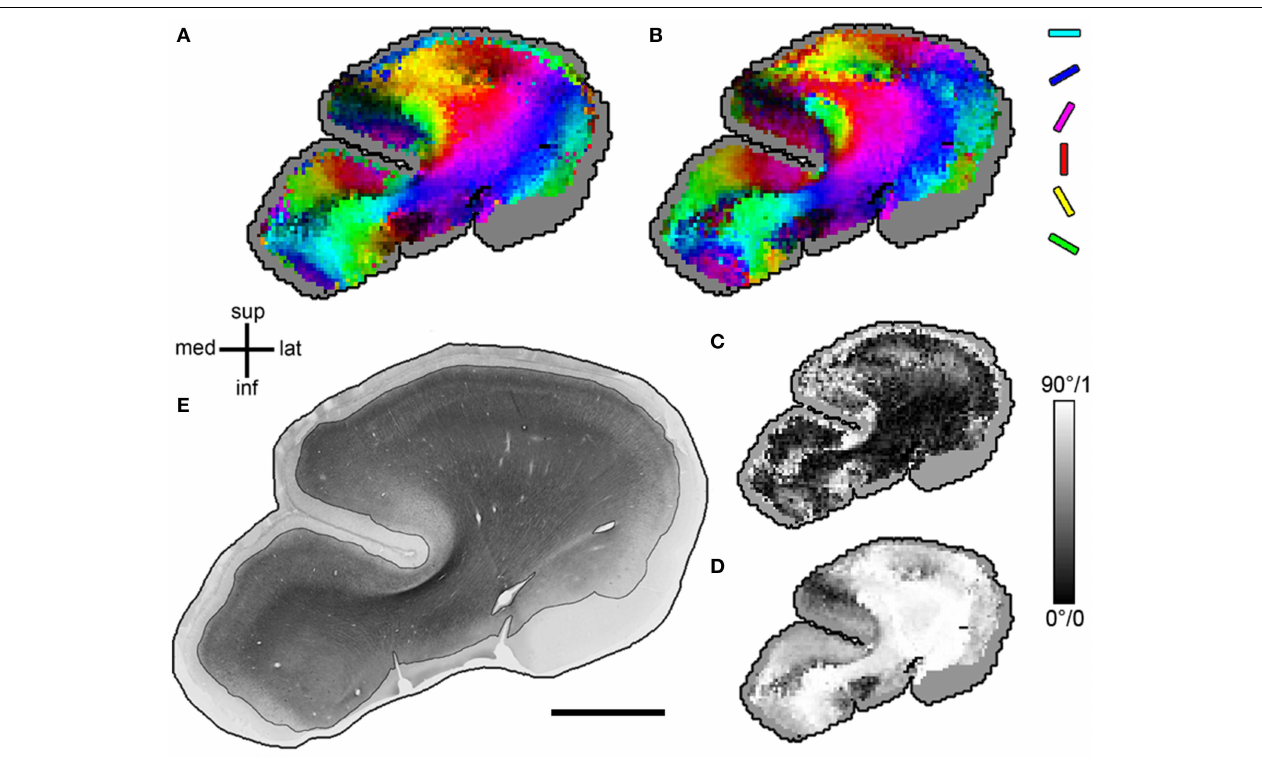
Mapping of projection length of diffusion tensors into the sectioning plane (ranging from 0 to 1). Note that a short projection length is a possible but not the only source of high angular difference in (C) . (E) Original section with stained area emphasized. In (A–D) , the parts without stained fiber material are displayed in gray. Size (A–D) , 1 image pixel equals 1 voxel (340 µ m); (E) , scale bar =